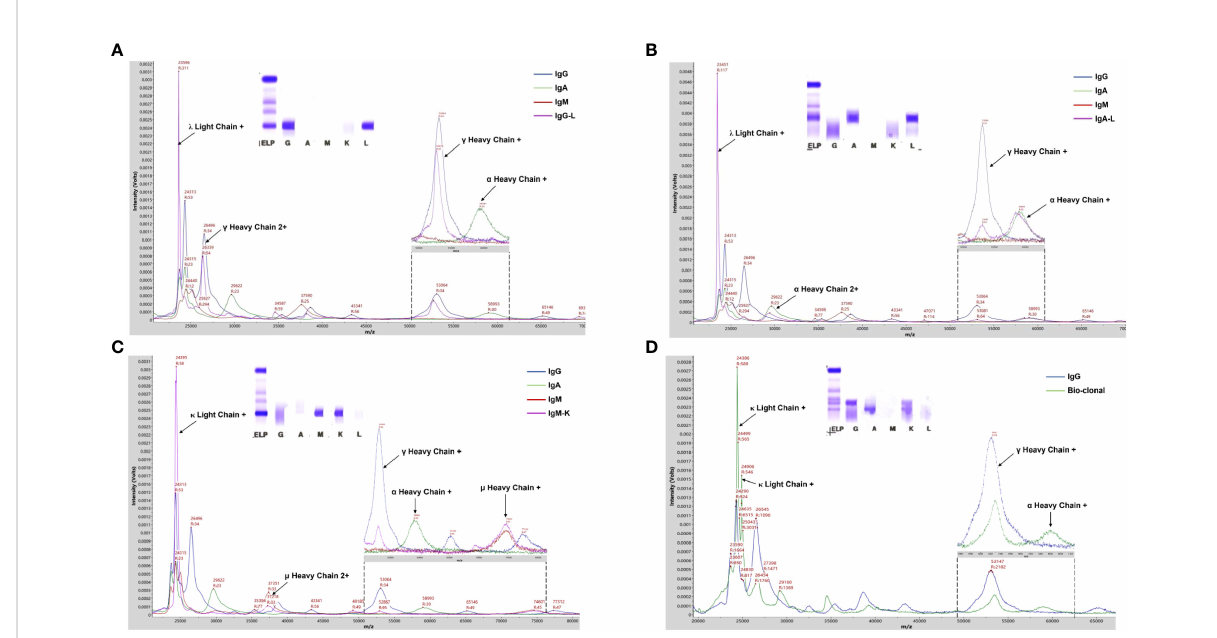
FIGURE 3 MALDI-TOF MS analysis of serum samples from PCD patients. (A-C) Mass spectra from patient serum samples with IgG-L, IgA- Land IgM-K M- proteins showed typical g , a , and u heavy chains peaks, respectively. (D) Mass spectra from a patient with bi-clonal gammopathies reveled two types of M-proteins including IgG-K and IgA-K. Arrows indicated peaks correlated to the corresponding component of Ig molecules. Mass spectra from IgG/A/M standard and patient serum samples were in different colors.